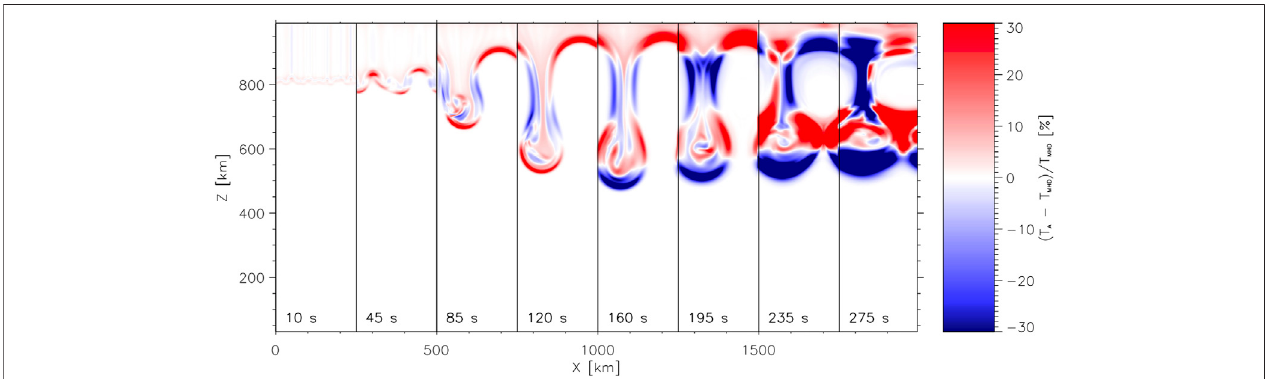
FIGURE 8 | Difference between the temperature variations in a RTi simulation including ambipolar diffusion and an equivalent ideal simulation. The time elapsed is given at the bottom of each panel. Red/blue colors mean hotter/cooler plasma in the simulations with ambipolar diffusion. Credit: Khomenko et al. (2014b), A&A 565, A45, reproduced with permission © ESO.